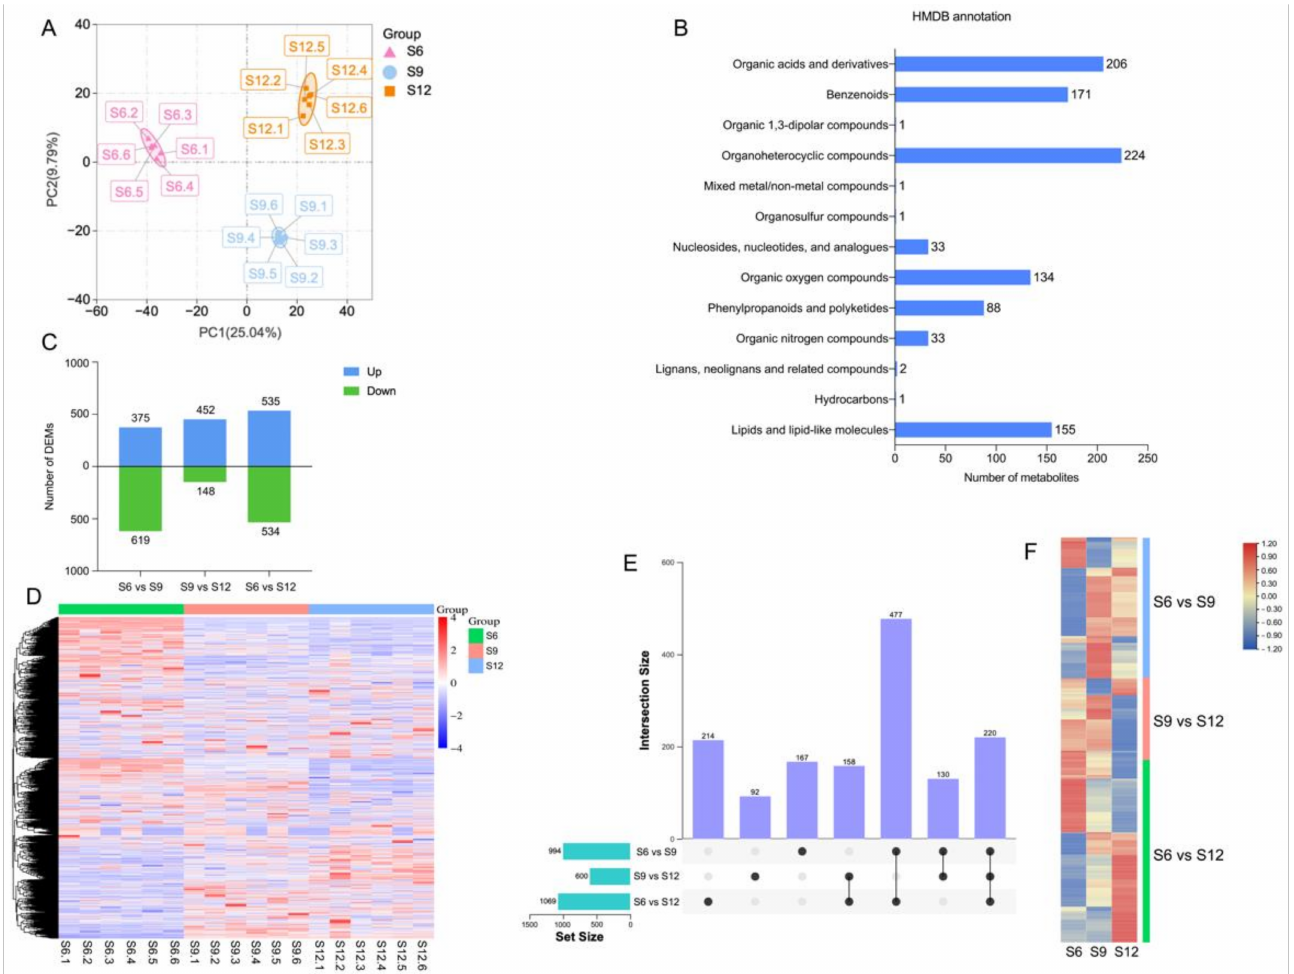
Figure 2. Metabolome analysis of sweet cherries during development. ( A ) PCA analysis of metabo- lites at each developmental stage; ( B ) HMDB classification annotation of metabolites; ( C ) the number of DEMs compared at any two different developmental stages; the number of upregulated and downregulated metabolites is represented by the bars above and below the x -axis, respectively; ( D ) heatmap of all DEMs at three developmental stages, with colors indicating the relative level content of each DEM, from low (purple) to high (red); ( E ) upset plots of ubiquitously and exclusively expressed DEMs in pairwise comparisons across developmental stages; ( F ) heatmap of expression patterns of unique DEMs in the three comparison groups, with different colors representing the relative level content of each DEM, from low (blue) to high